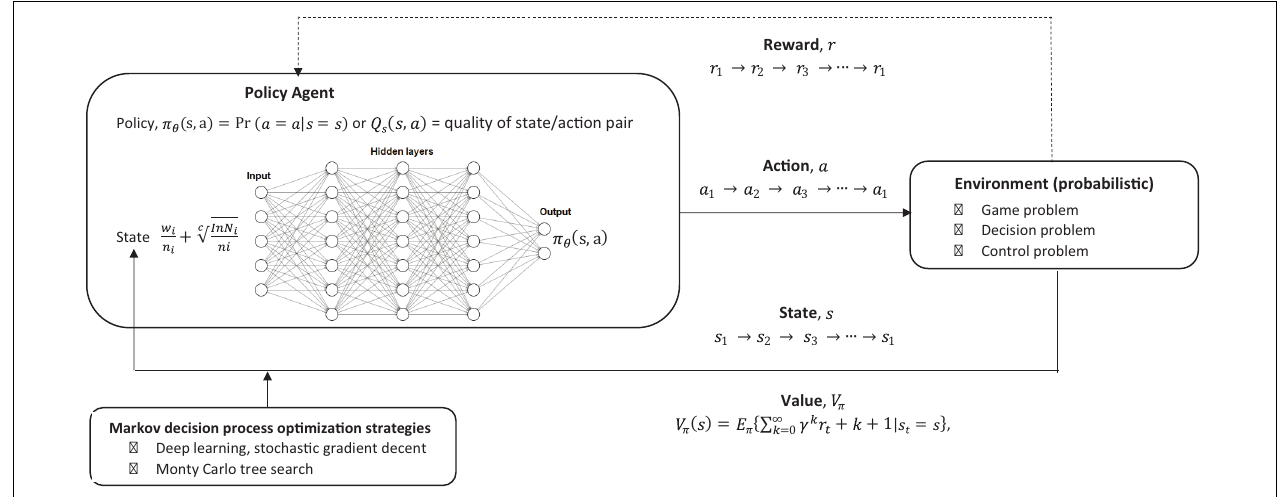
FIGURE 8 | Overview of reinforcement learning machine learning framework, but with a deep neural network implemented as policy optimizer.